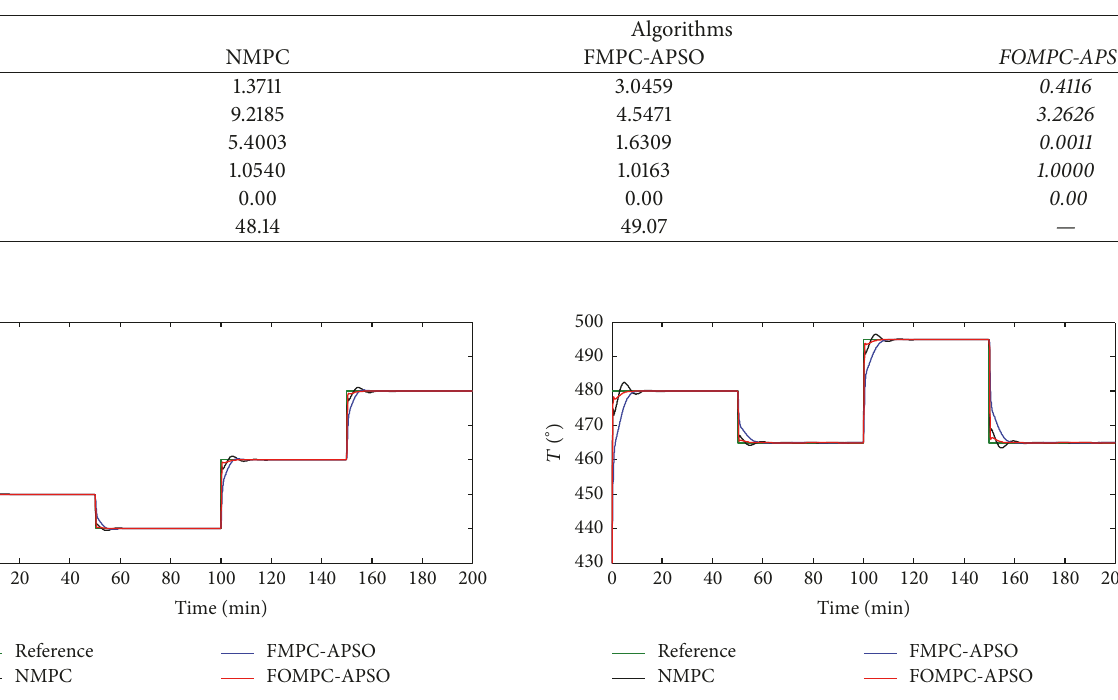
Table 6: Pi found by different methods.